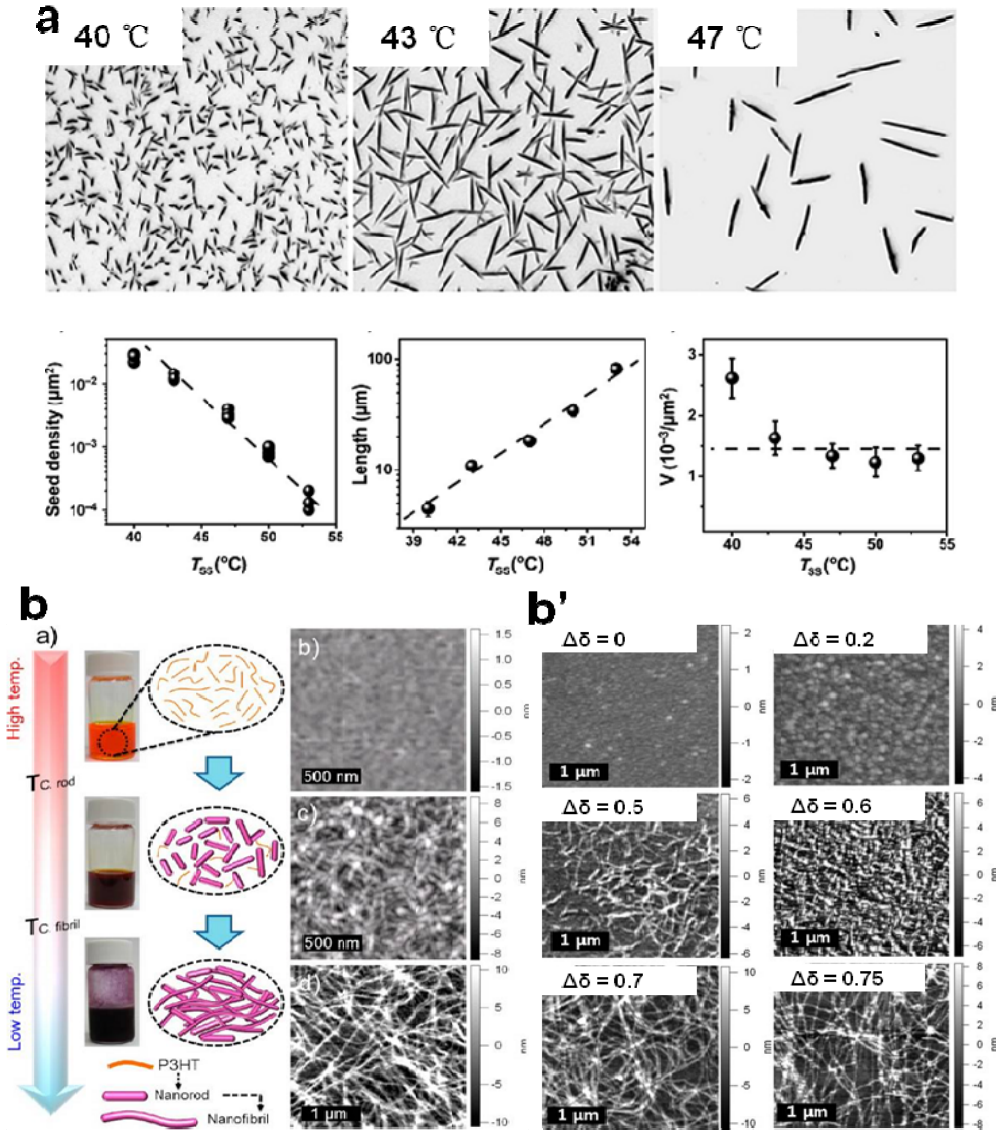
on the crystallization morphology (optical microscopy Figure 20. ( a ) The influence of T ss images with a range of 100 × 100 μ m 2 ), seed density, crystal length and crystal density (Adapted with permission from [77]. Copyright 2012 Wiley-VCH Verlag); The influence of solution temperatures on the solution state and film morphology during self-seeding in ( b ) and the influence of solubility parameter difference between P3HT and solvent on the morphology of films cast from solutions according to the same self-seeding procedures in ( b’ ), (Adapted with permission from [152]. Copyright 2012 American Chemical Society); and ( c ) The influence of temperatures of solution during sonication on aggregation in solution and fibril length and the TEM images of films cast from solution undergoing sonication at different temperatures (scale bar: 500 nm) (Adapted with permission from [53]. Copyright 2012 American Chemical